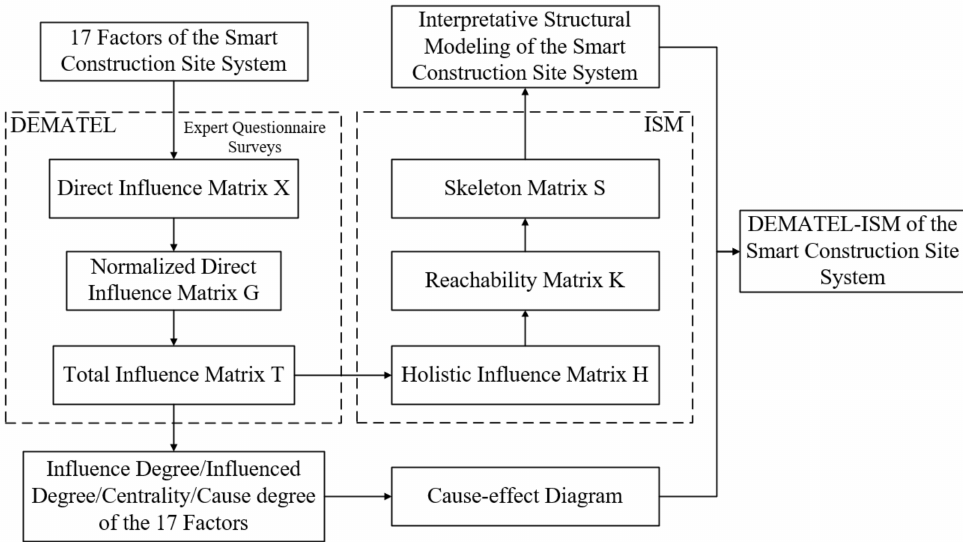
Figure 2. Research framework and factor analysis